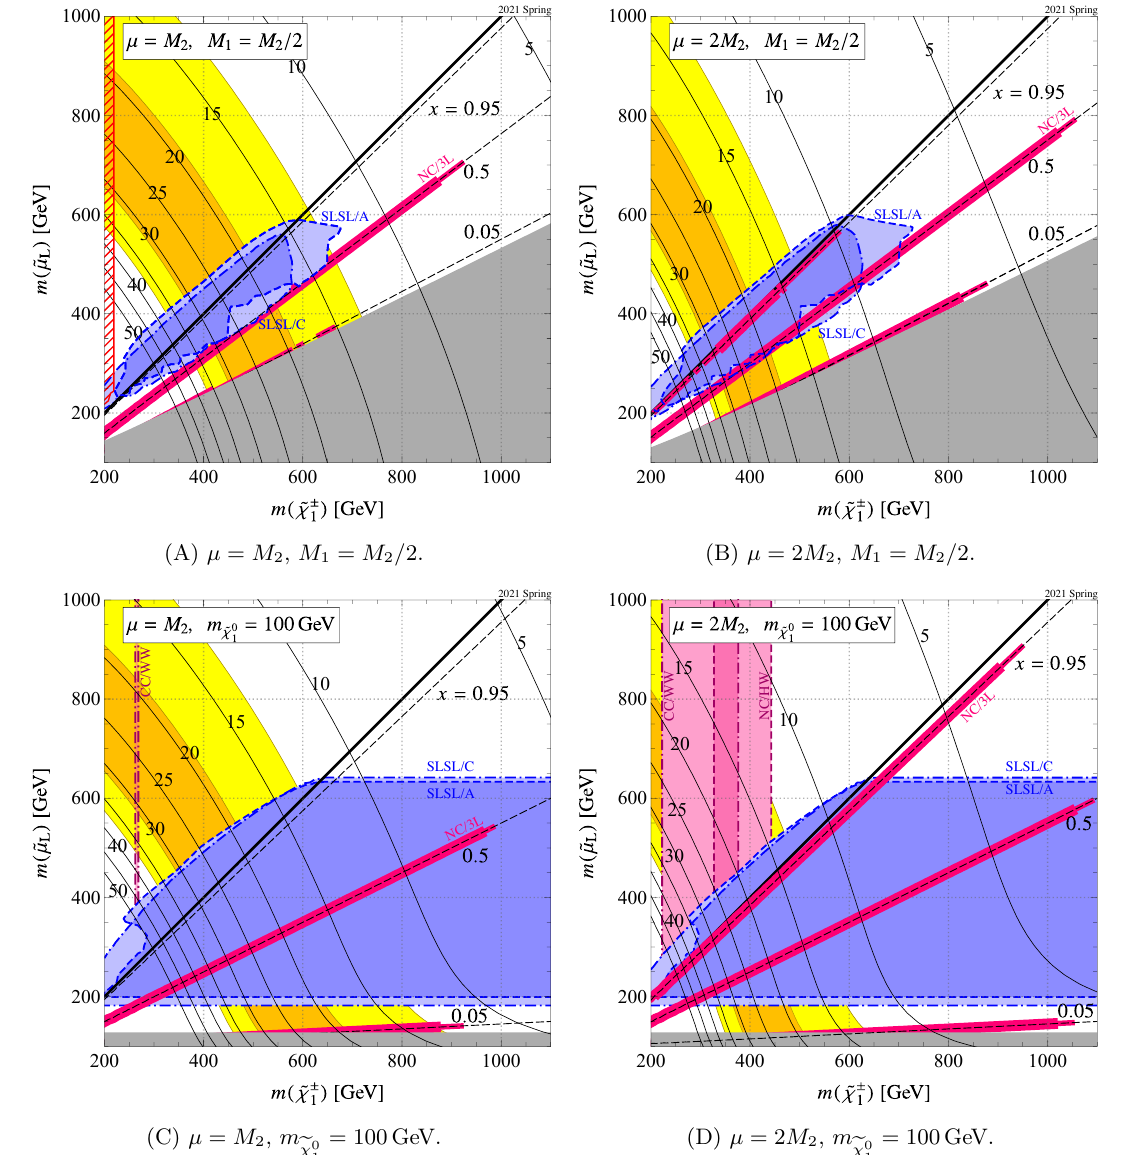
Figure 1. The 2021 Spring summary of the chargino-dominated SUSY scenario for the muon g − 2 anomaly. Four benchmark parameter planes are considered, where the WHL contribution is sizable and a SUSY explains the anomaly at the 1 σ ( 2 σ ) level in the orange-filled (yellow-filled) regions; µ a SUSY × 10 10 is shown by the black contours (but up to 50). The thick black line corresponds to µ = m . The gray-filled region, where the LSP is m ν , and the red-hatched region in (A), which e e µ L e χ ± 1 corresponds to a compressed spectrum, are not studied. The red-filled and blue-filled regions are excluded by the LHC experiment [50, 52, 53]. We also analyzed the results of refs. [54, 55] but only on the model points with x = 0 . 05 , 0 . 5 , and 0 . 95 [see eq. (2.11)]; the excluded ranges are shown by the magenta bars. Detailed description of the LHC constraints is provided in our previous work